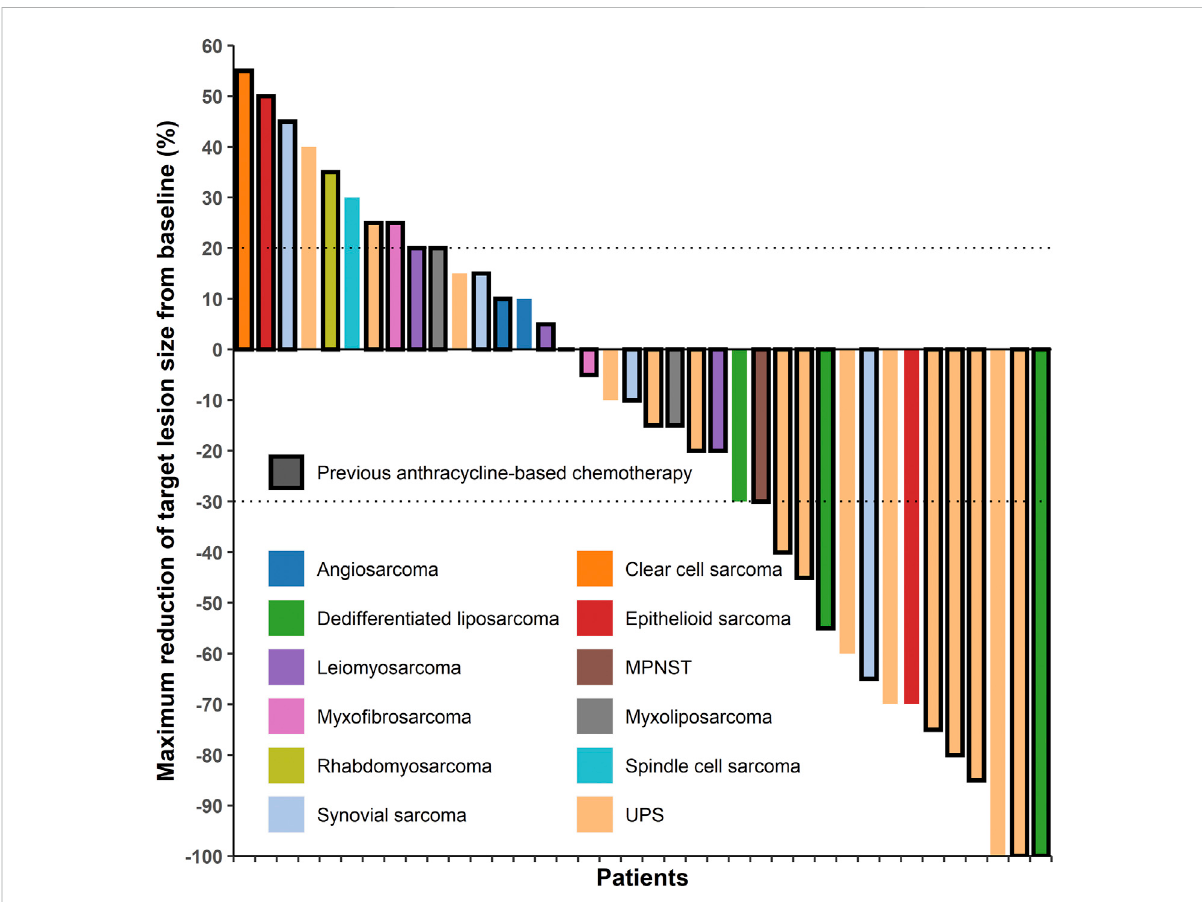
FIGURE 1 Target lesion changes in patients with soft tissue sarcoma treated with programmed cell death protein one inhibitor plus doxorubicin. The horizontal axis represents different patients and the vertical axis represents the percentage of change in the target lesions. Twenty-eight patients whohadreceivedanthracycline-basedchemotherapyaremarkedwithablackborder.Twopatientswithundifferentiatedpleomorphicsarcomaand one patient with dedifferentiated liposarcoma had a complete response (100% decrease in target lesion size), twelve patients had a partial response (30% and more decrease in target lesion size), twelve patients had stable disease ( < 20% increase and < 30% decrease in target lesion size), and eleven patients had progressive disease (20% and more increase in target lesion size). MPNST, malignant peripheral nerve sheath tumor; UPS, undifferentiated pleomorphic sarcoma.